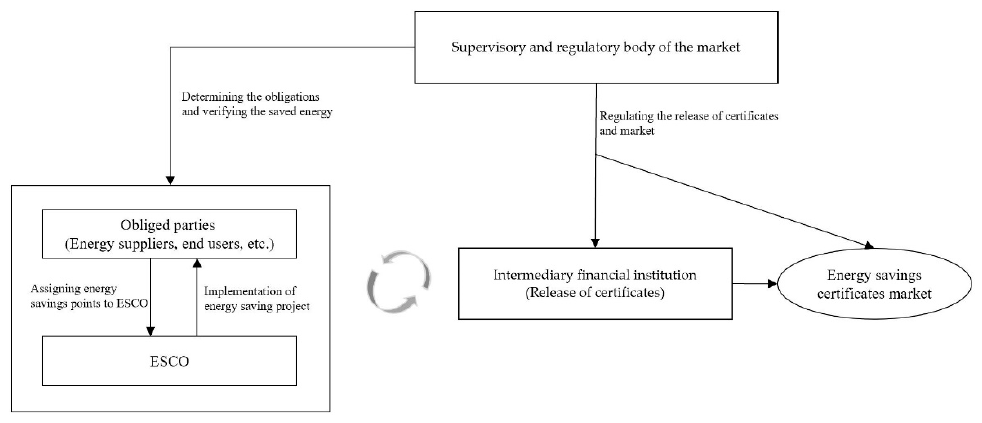
Figure 1. The schematic view of the Energy Savings Certificates (ESC) market structure [13].